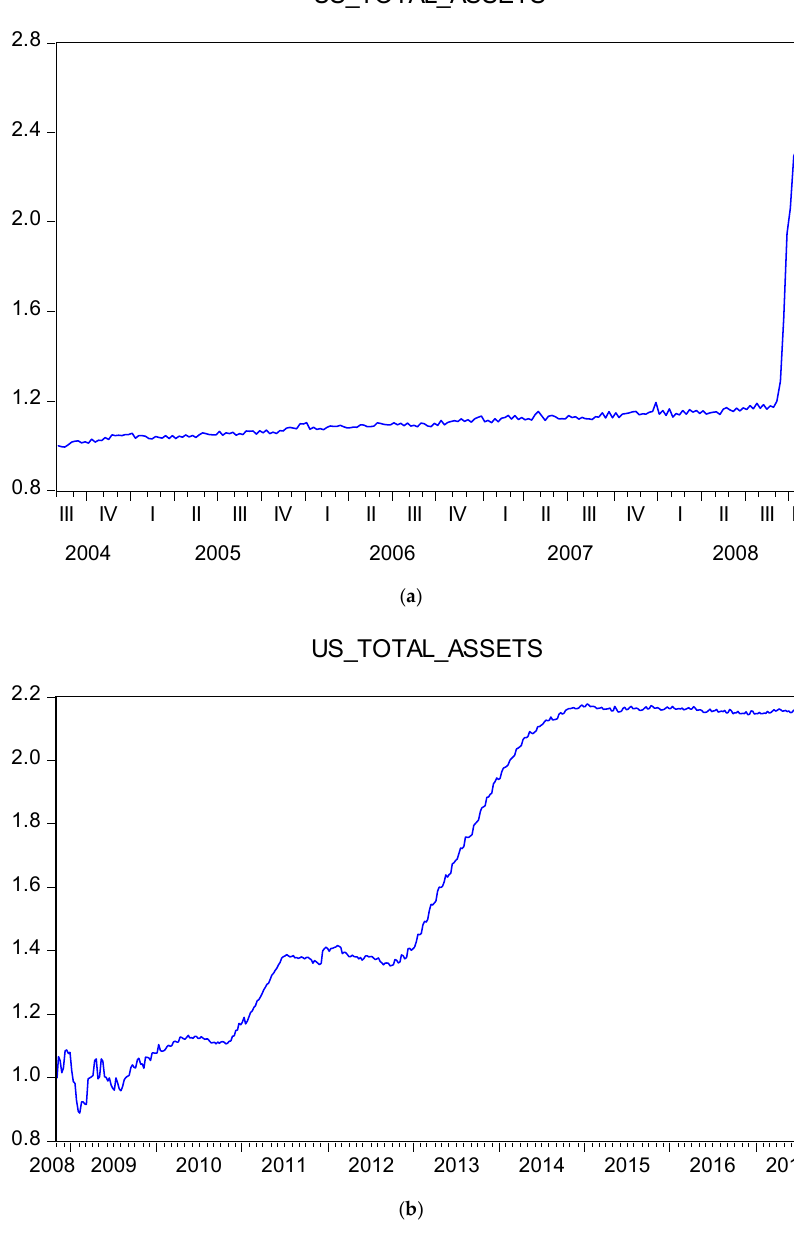
Figure 1. ( a ) The United States Federal Reserve (US Fed)’s total assets in the pre-quantitative easing (QE) period; ( b ) the Fed’s total assets after the launch of its unconventional monetary policy (QE and post-QE periods).